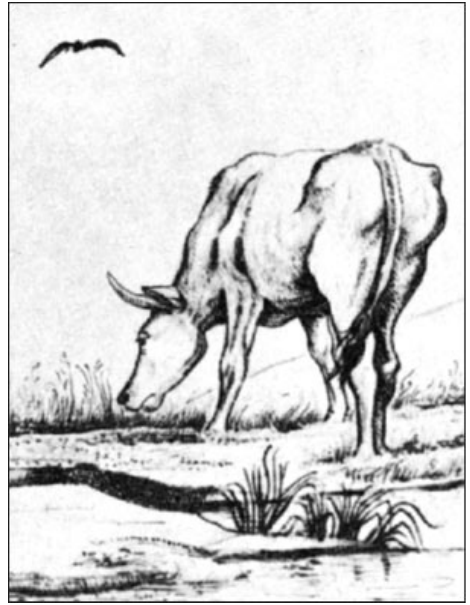
Figure 43. Konstantin Batiushkov. A Cow , 1850s (?). State Literary Museum, Moscow.